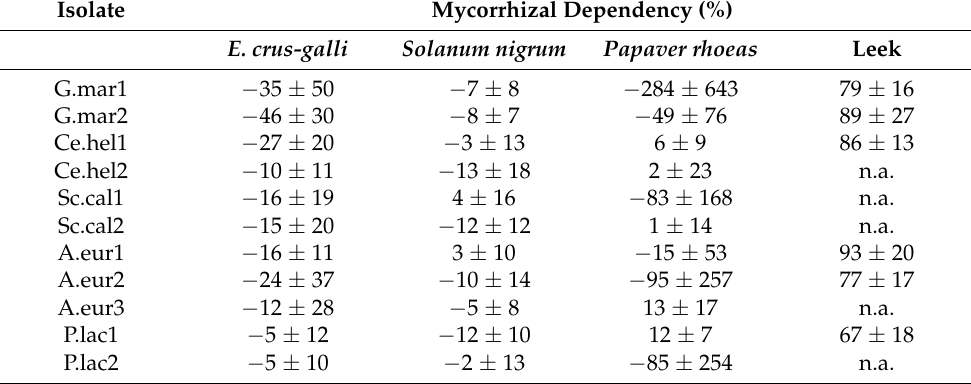
Table 2. Cont. Isolate